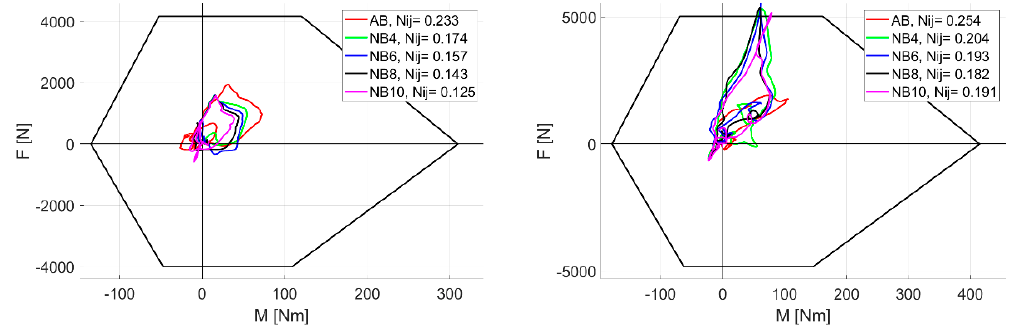
Figure 8. Nij criterion for average Male, P50, 28 YO, 178 cm, 76 kg ( left ) and Male, P95, 54 YO, 184 cm, 95 kg ( right ).